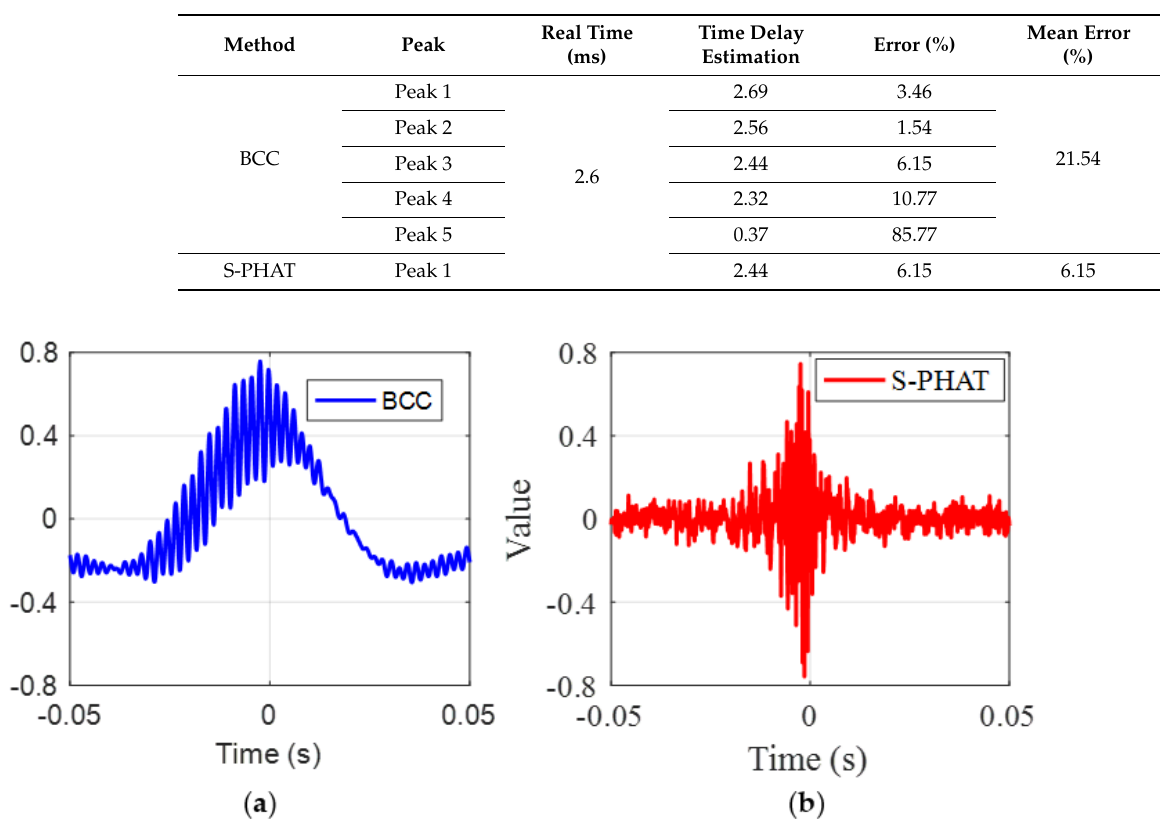
Table 1. Leak localization results.